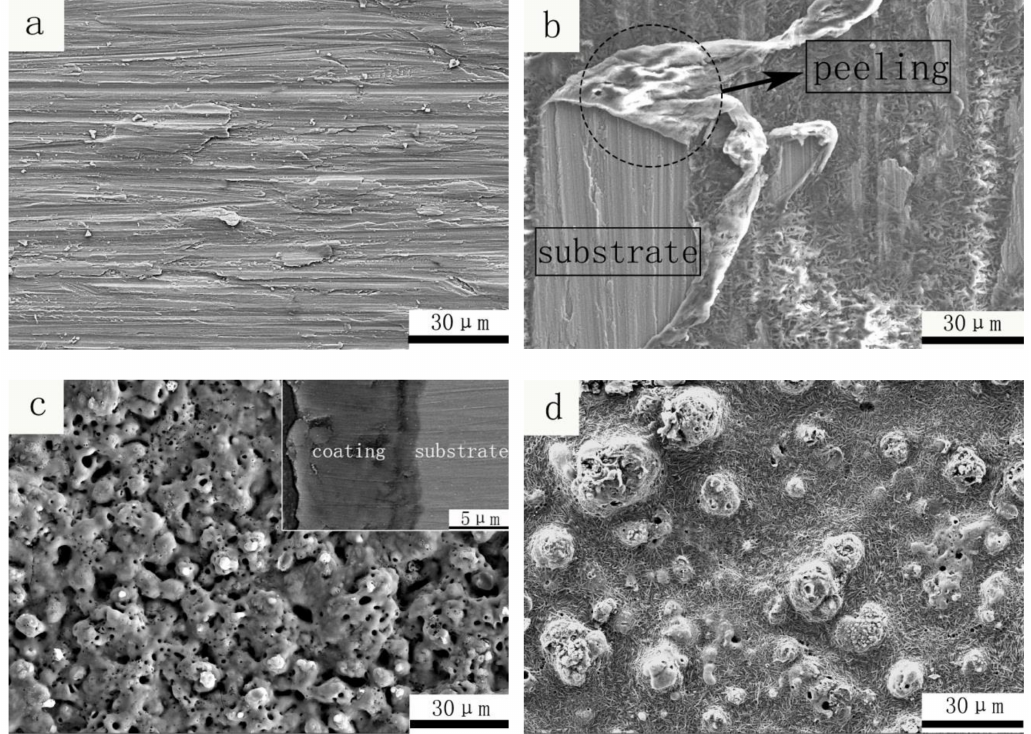
Figure 2. Morphologies of ( a ) titanium substrate; ( b ) Ti-polytetrafluoroethylene (PTFE) coating; ( c ) plasma electrolytic oxidation (PEO) TiO 2 coating; ( d ) PEO–PTFE composite